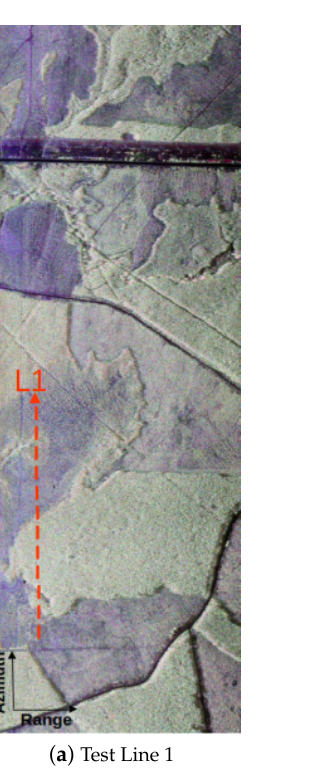
Figure 9. P-MUSIC tomograms with model order larger than 2. The black line is the LiDAR ground and tree top elevation